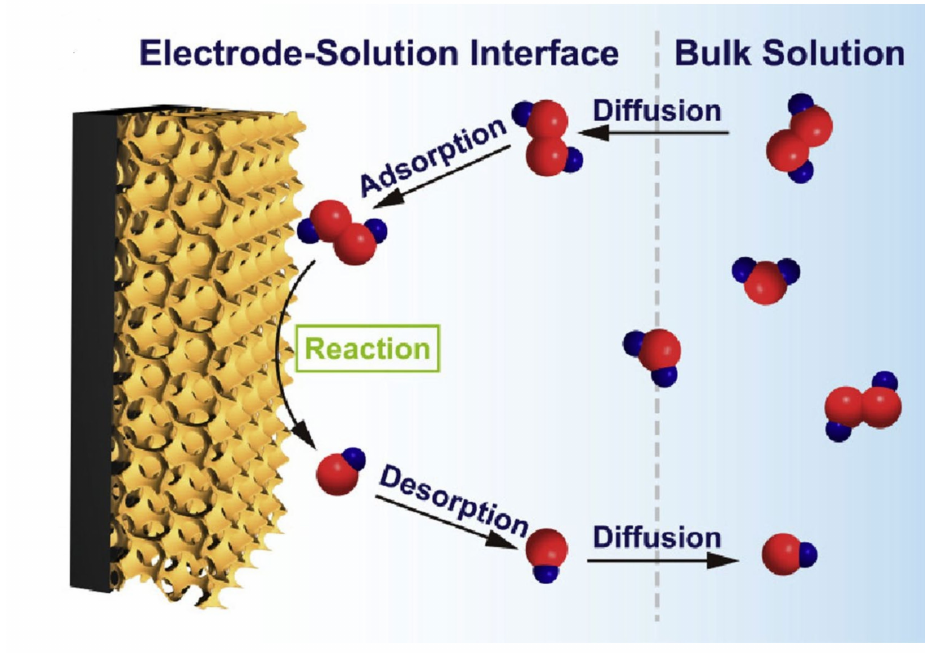
Figure 2. Schematic diagram of the overall process steps on a perovskite/glassy carbon electrode (GCE) [21]. Reproduced with the permission from